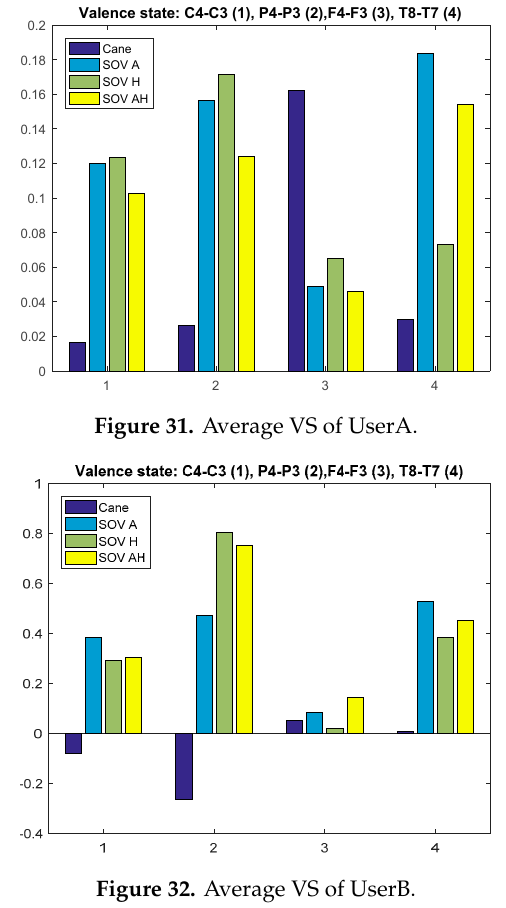
Figure 34. VS evolution in time for UserB. 6.6. Limitation of This Study The limitations of the current study reside in the fact that we performed the tests with a small number of users for both categories (early-blind and late-blind). Although the results were interesting and in line with the existing literature, a more thorough evaluation should be realized. In addition, the EEG recordings were performed using a limited number of electrodes. As future directions, we plan to use a more advanced EEG recording device, with a higher number of electrodes, and to improve the SoV device so that it would be lighter and more comfortable to be worn. The results of real-world experiments were strongly influenced by a consistent training period, similar to all users, which requires a great deal of time. Future work can extend the realistic scenarios of RW traveling for enhancing the impact of the study. 7. Conclusions This paper presented an experimental framework and a study based on EEG, HR, and GSR signal analysis, aiming to assess the brain cortex activation and affective reactions of the visually impaired persons to the stimuli provided by a sensory substitution device used for navigation in real- world scenarios, compared to the white cane navigation. The study was focused on the evaluation of working memory load, visual cortex activation, and emotional experience when the VIPs perceived audio, haptic, and multimodal stimuli during a navigation task in five different types of scenarios.